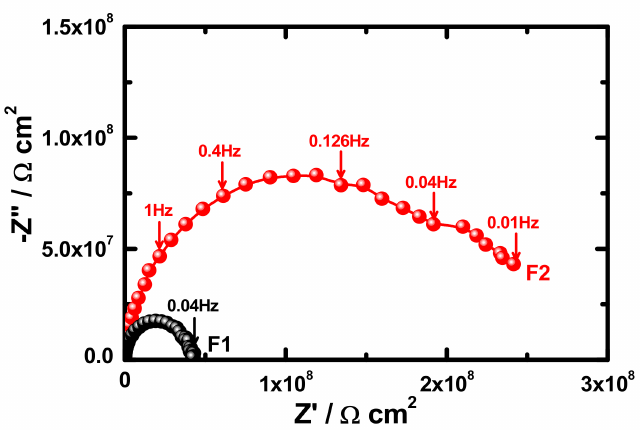
Figure 10. Nyquist plots for coatings F1 and F2 after 30 days immersion in the 3.5% NaCl solutions.